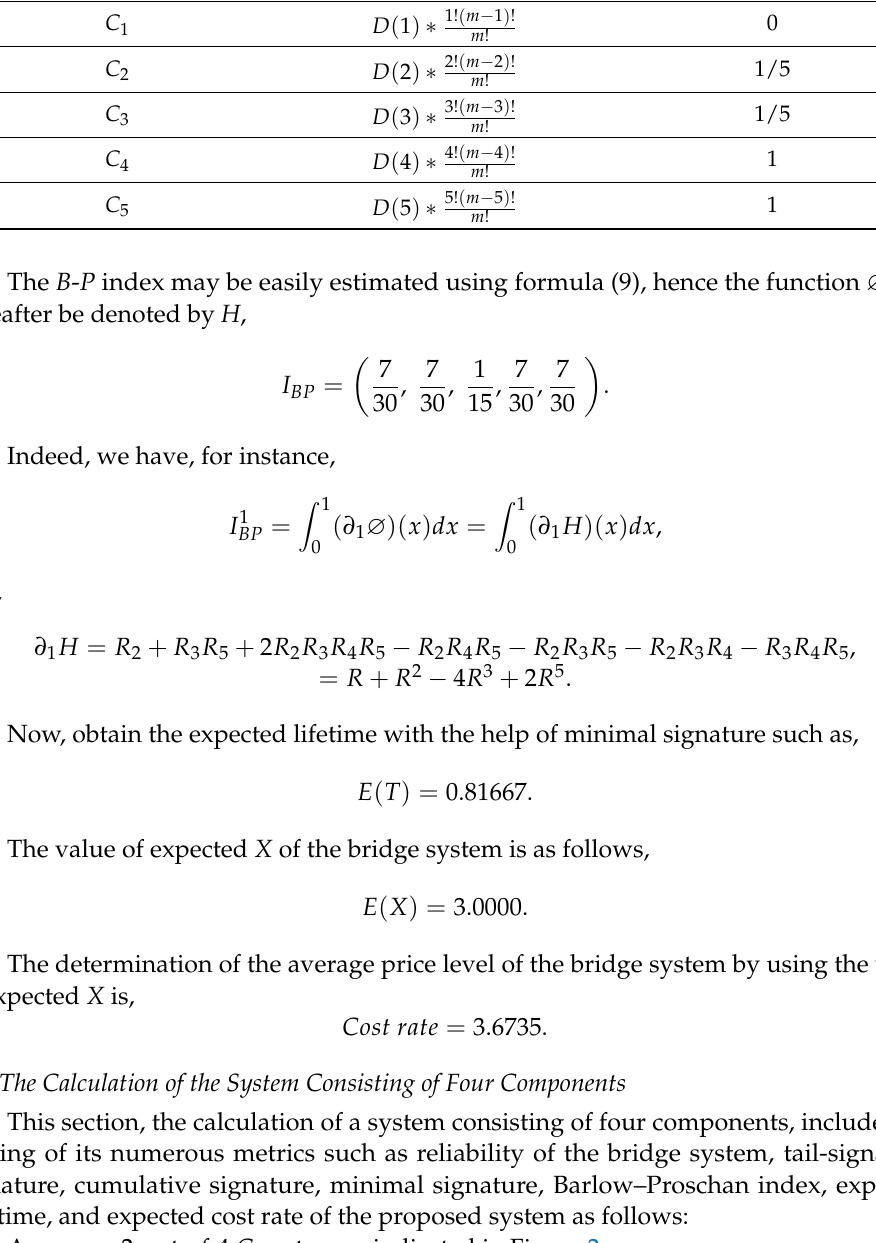
Table 3. The cumulative signature of the bridge system.